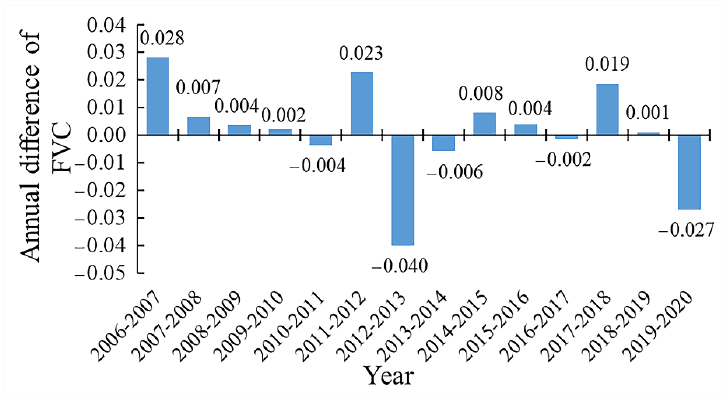
Figure 6. Annual FVC variance chart.